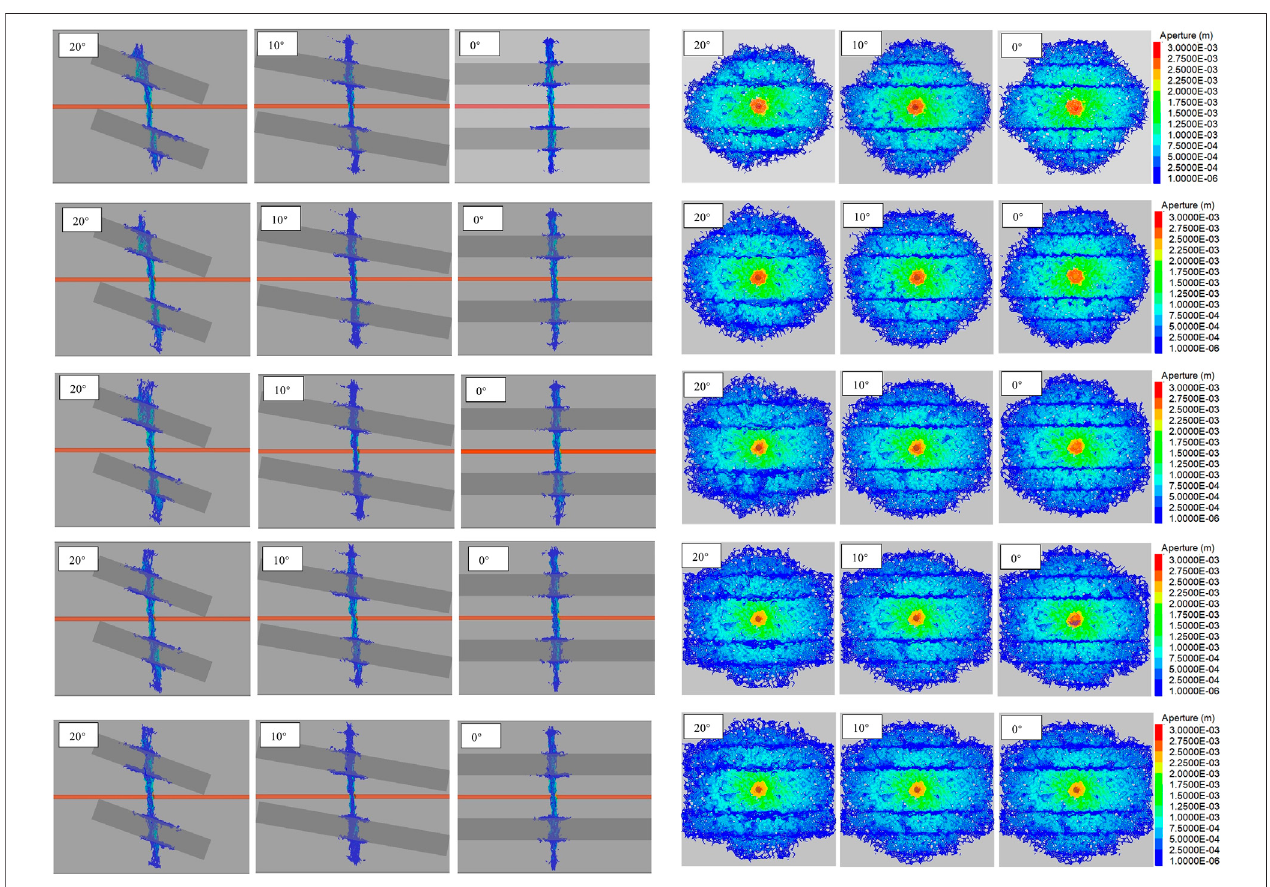
FIGURE 3 | Effects of caprock ’ s inclination and Young ’ s modulus on fracture propagation in a laminated reservoir. The images show the model (A) front view and (B) side view with Young ’ s modulus of 20 MPa, 27.7 MPa, 40 MPa, 50 MPa, and 60 MPa.